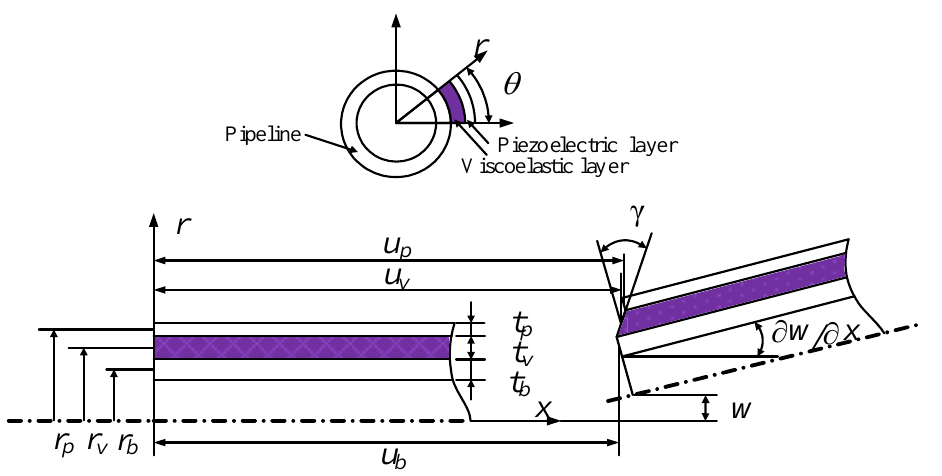
Figure 2. Deformation of the pipeline partially covered active constrained layer damping (ACLD). From the strain field and displacement field, the constitutive relation of ACLD pipe system can be obtained. For i = b, p, the displacement and strain of the pipeline and the piezoelectric constraining layer can be gained from the neutral axial displacement and the transverse displacement.